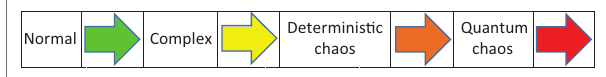
FIGURE 3: The normal–complex–deterministic chaos–quantum chaos